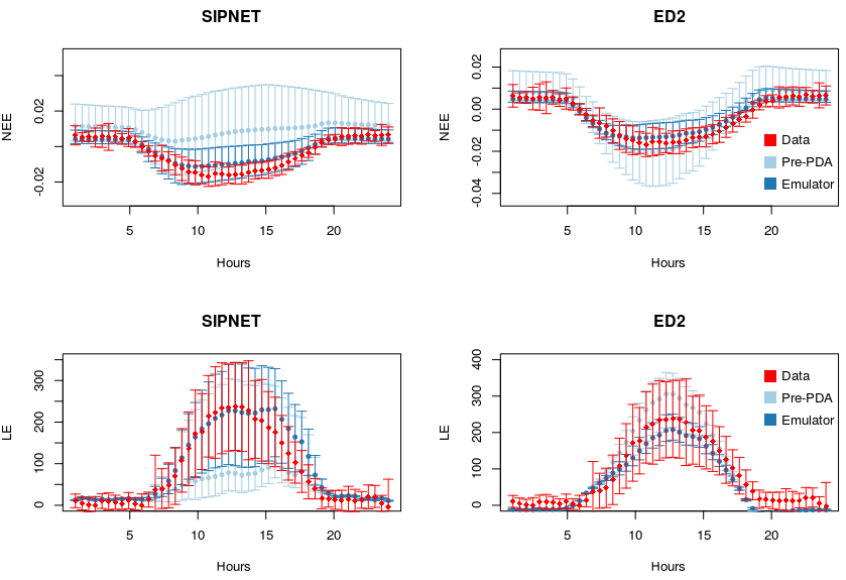
Figure A6. Diurnal cycles of NEE and LE fluxes for June–July–August over the simulation period (2005–2006) before and after the calibra- tion. Error bars represent the variation over the JJA period. Units are the same as above: NEE: kgCm − 2 day − 1 and LE: Wm − 2